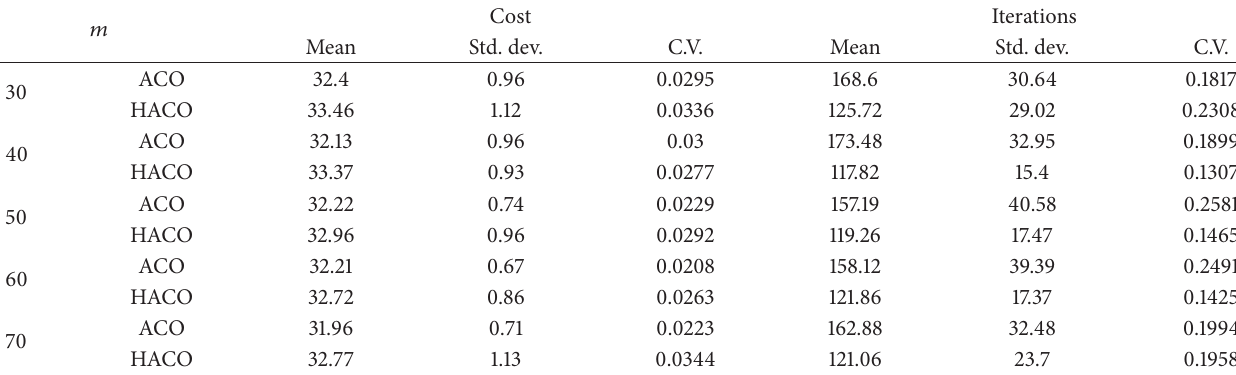
Table 1: Results with different 𝑚 (cost: million CNY; iterations: times).